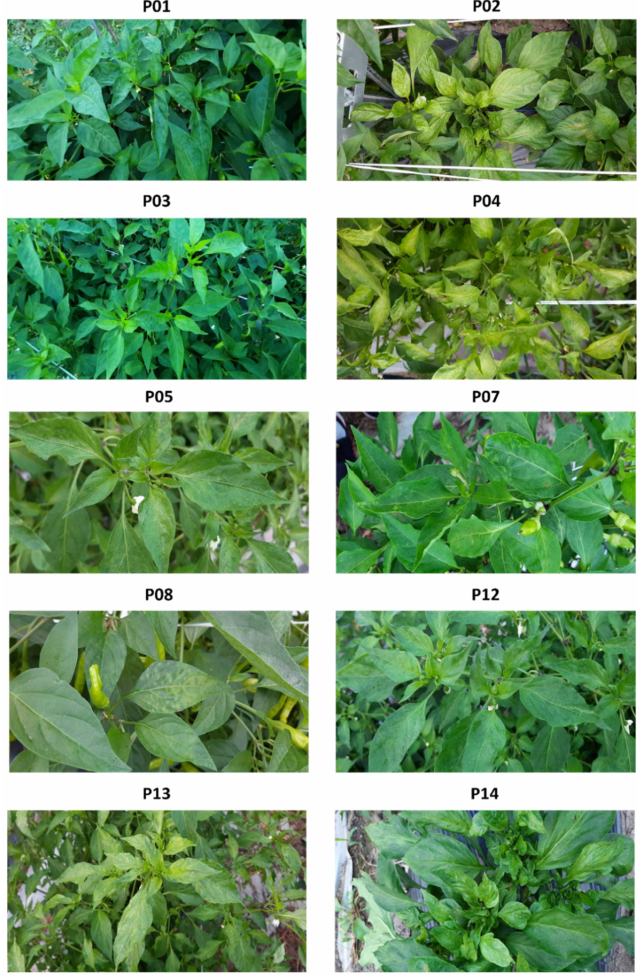
Figure 1. Images of 10 representative pepper cultivars. Few cultivars, such as P01 and P03, did not show any visible viral disease symptoms, while all paprika plants, such as P02 and P14, displayed very severe disease symptoms, such as stunting, and abnormal growth. Most pepper cultivars displayed mild symptoms, such as chlorosis, curling, mosaic, mottling, and vein